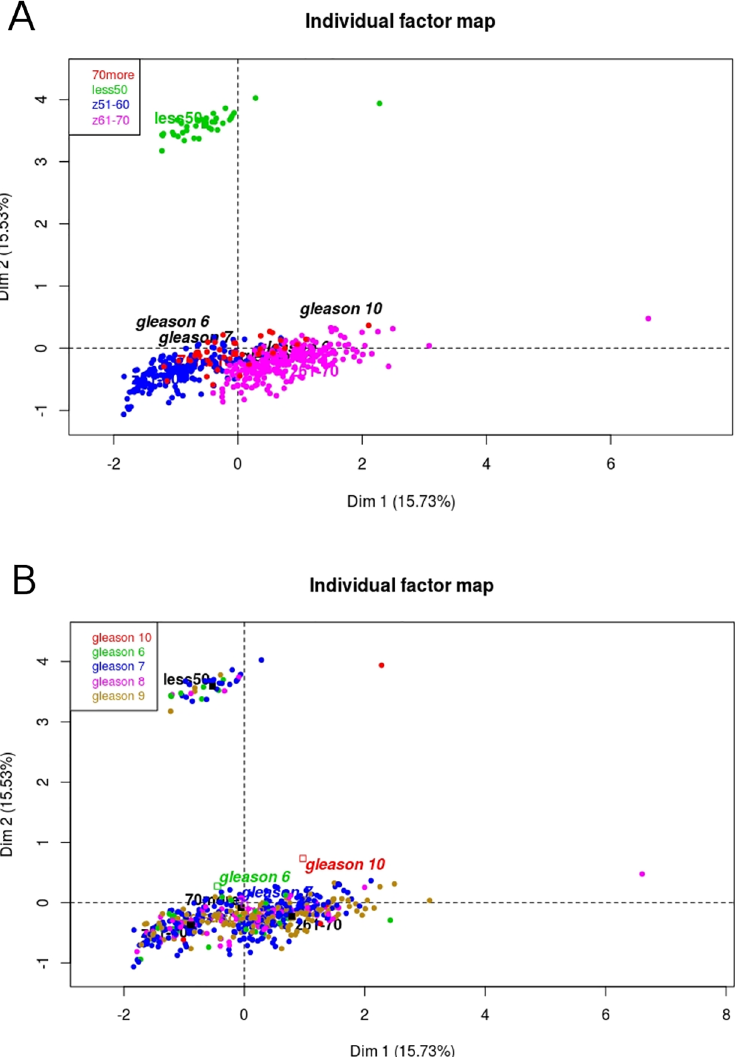
Fig 2. Distinct biology of PRAD patients aged (cid:20) 50 years old relates to different profile of EMT. The expressionof selectedEMT markers indicatescompletelydifferent partitioningof PRAD patients aged (cid:20) 50 years old (A), however equable distributionof Gleason score amongst patients (B). The projectionsalong Dim2 show distinct groupingof patients aged (cid:20) 50 years old in association with different profile of selected EMT markers with simultaneous similar character of tumor diagnosedin older males